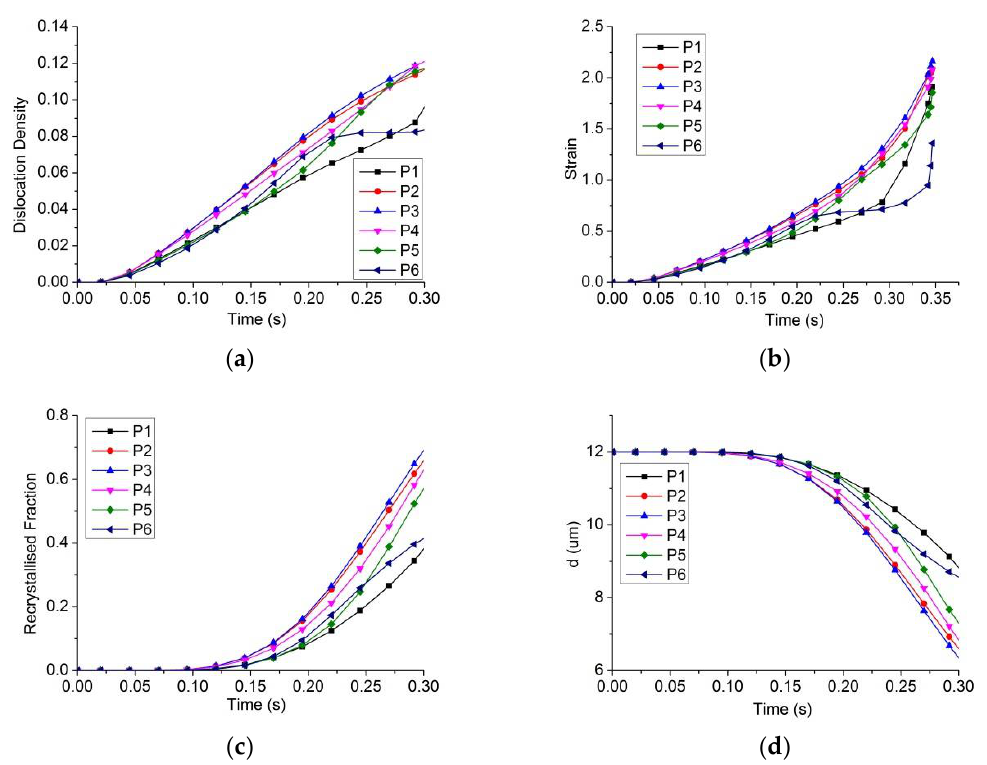
Figure 14. Distribution of variables at different points 1–6. ( a ) Normalized dislocation density; ( b ) Equivalent strain; ( c ) Recrystallization fraction; ( d ) Grain size.